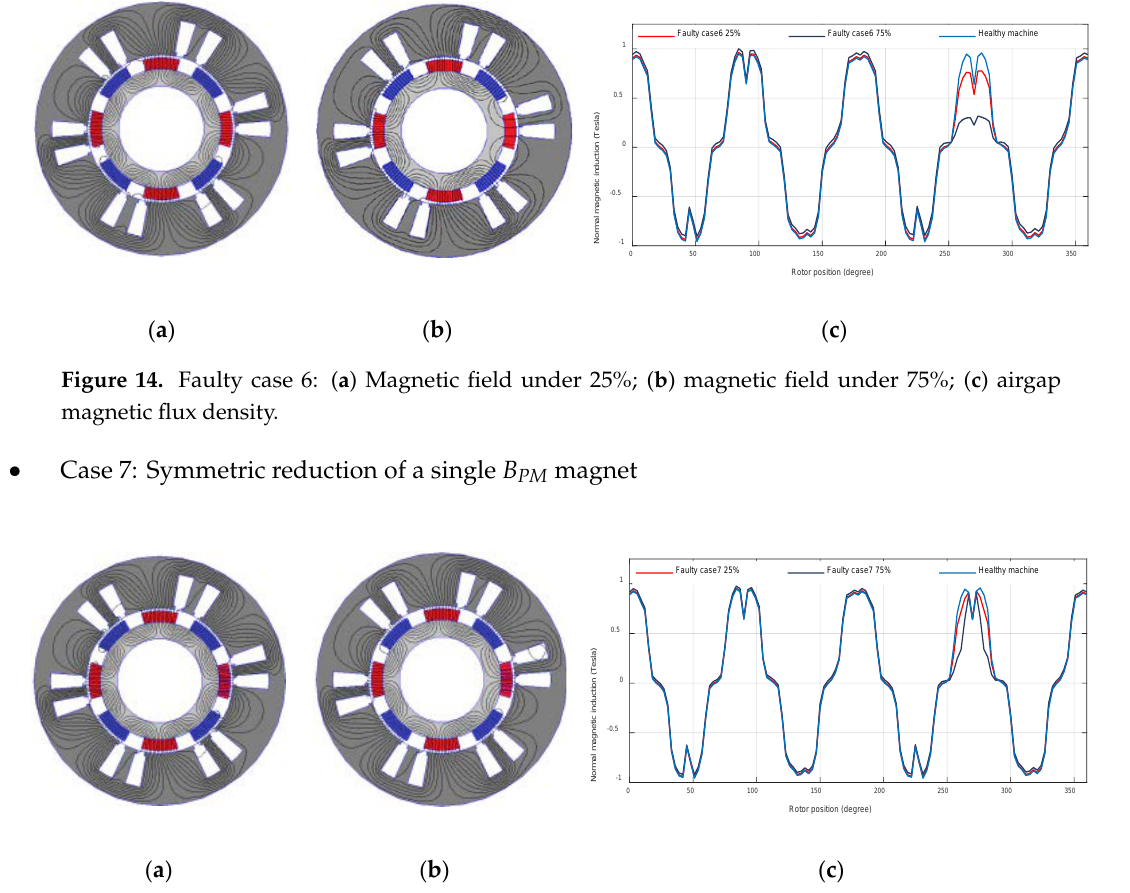
Figure 15. Faulty case 7: ( a ) Magnetic field under 25%; ( b ) magnetic field under 75%; ( c ) airgap magnetic flux density.